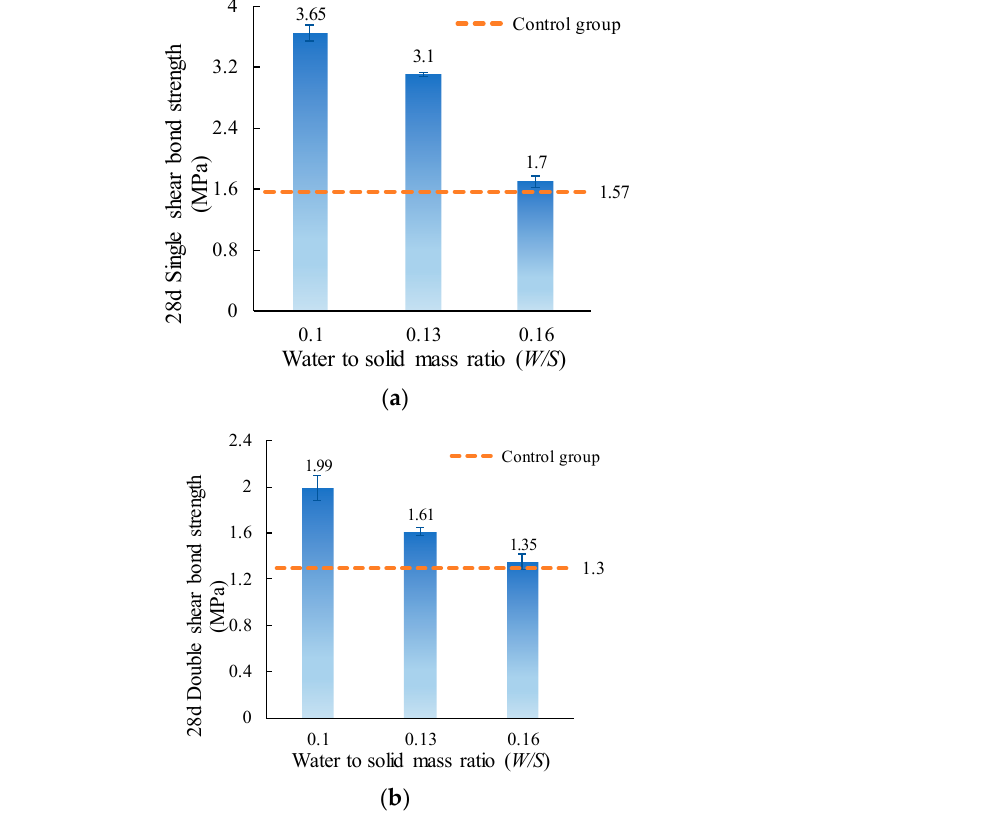
Figure 5. ( a ) Single shear bond strength and ( b ) double shear bond strength of specimens with varying W / S .